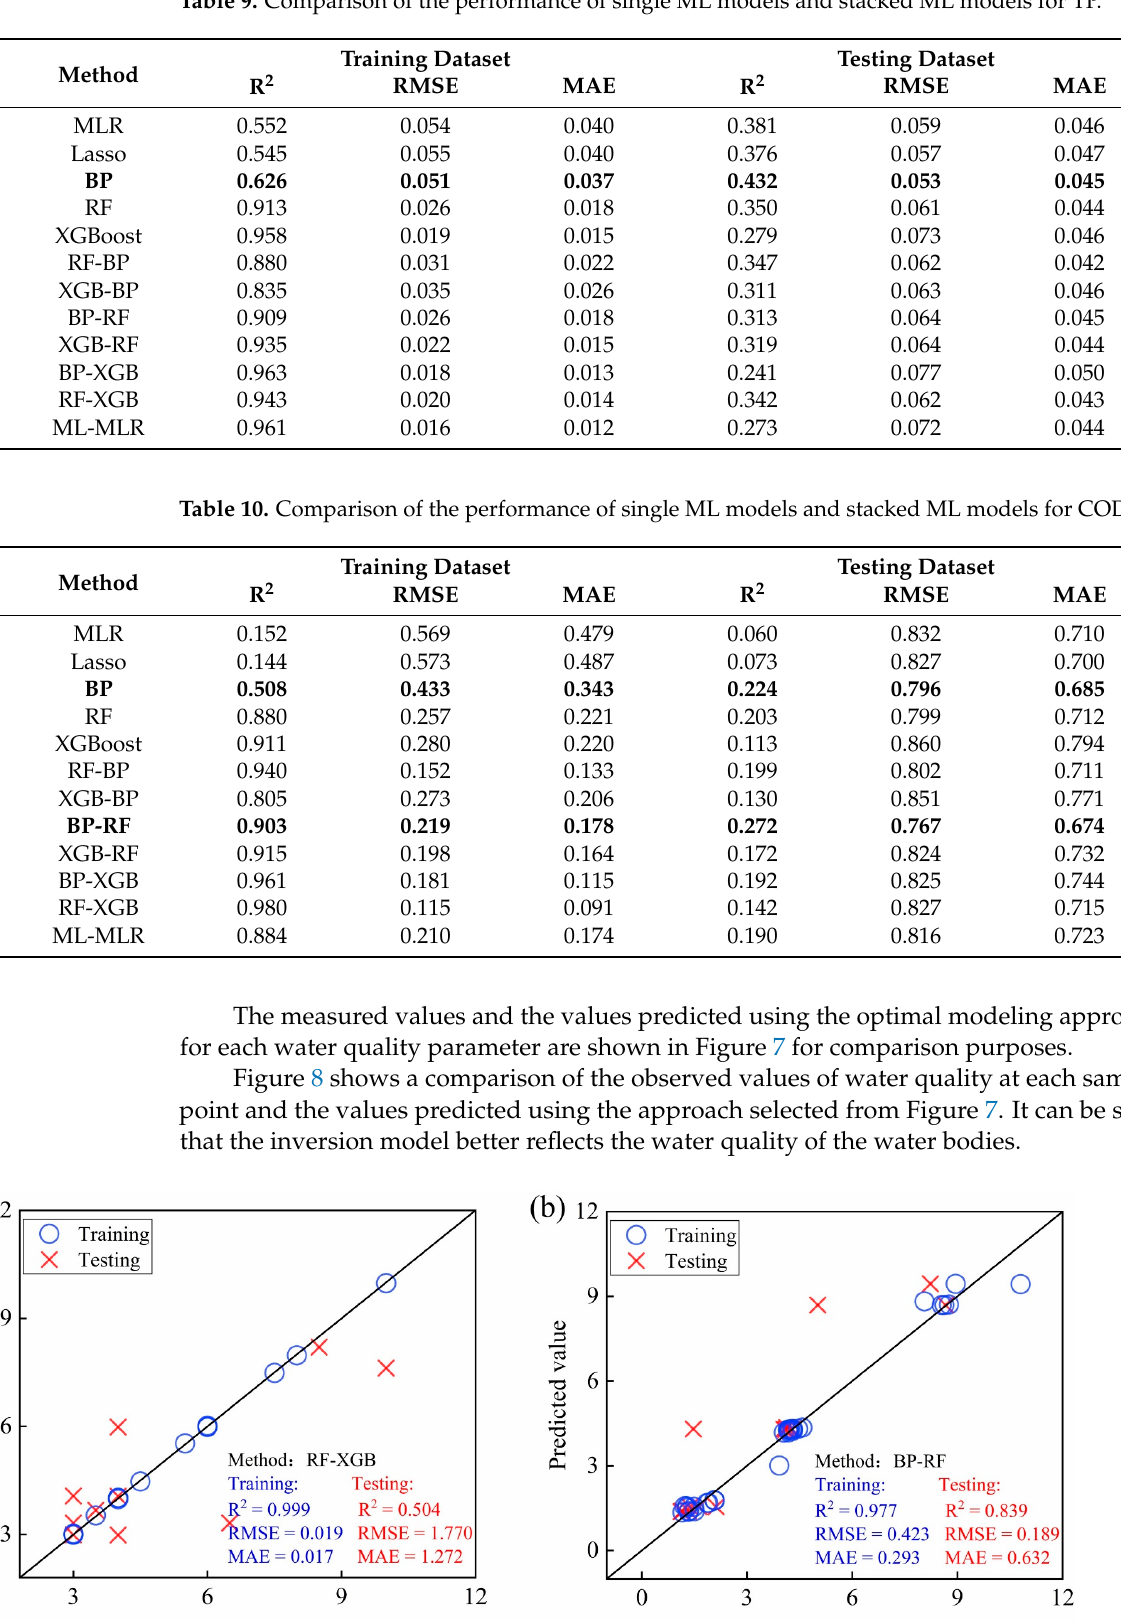
Table 9. Comparison of the performance of single ML models and stacked ML models for TP.